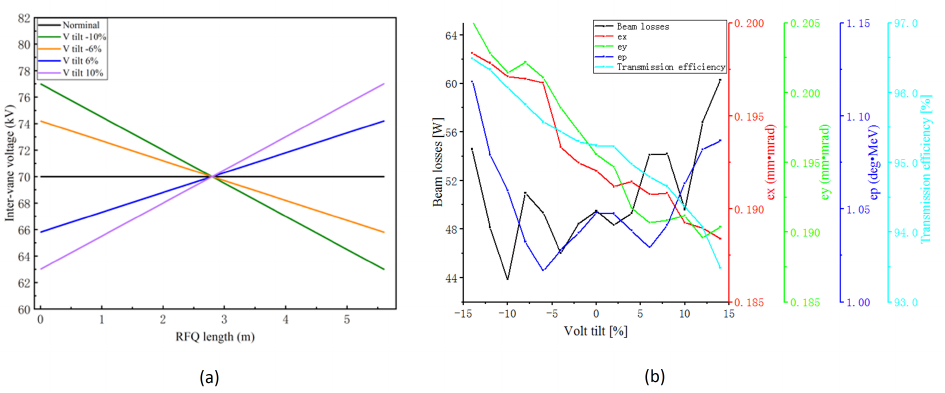
Figure 6. Inner-vane voltage tilt error. ( a ) Inner-vane voltage tilt, ( b ) Simulation results.